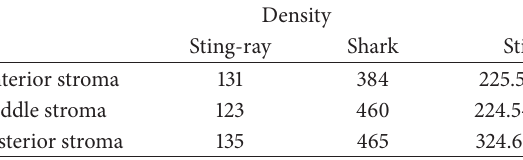
Table 2: Mean area of proteoglycans of anterior, middle, and posterior stroma of stingray and